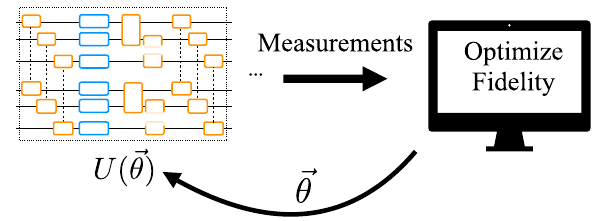
Fig. 11 Schematic of the QAOA algorithm to prepare the TFD for the transverse Ising model. The algorithm consists of a parameterized quantum circuit, U ( θ ) = ··· U 2 (θ 2 ) U 1 (θ 1 ) , implementedon a quantum computer,wheretheangles θ arefoundbyaclassicalcomputer.Usually, one finds these angles in a classical-quantum feedback loop, where the classical computer updates θ based on the output of the quantum computer. Detailsofthegatesusedinthequantum circuitareinFig. 12a (cid:12) ψ( θ ) | H | ψ( θ ) (cid:7) ,andtheloopcontinuesuntil (cid:12) ψ( θ ) | H | ψ( θ )